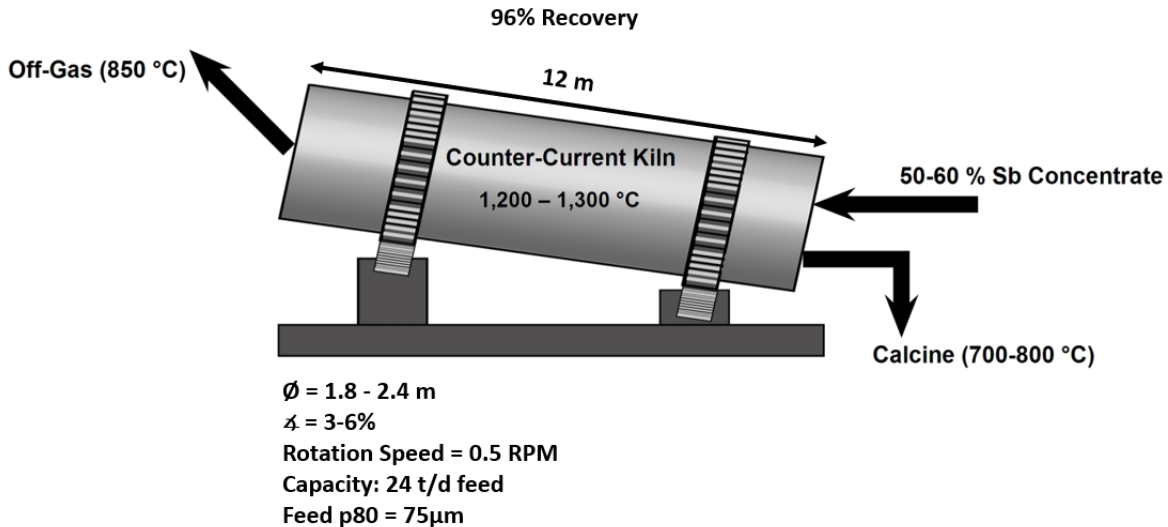
Figure 5 . Schematic visualization of flash volatilization counter-current kiln (adapted from [2]).